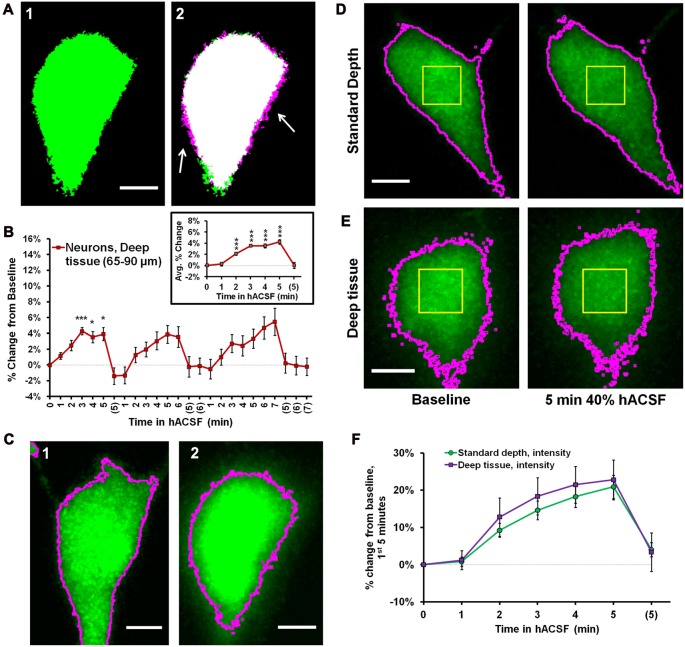
Intensity measurements reveal similar volume change between superficial and deep neurons. (A) Representative thresholded images of a Thy1-eGFP neuron taken from deep tissue (~65–90 μm below slice surface) at baseline (A1) and 5 min 40% hACSF (A2) time points. Magenta regions (indicated by white arrows) show areas of cell volume increase. (B) Volume change in deep Thy1-eGFP neurons exposed to 40% hACSF, measured using our standard analysis method. Inset displays average percent change across hACSF applications. The apparent reduction in volume change as compared to shallower neurons (e.g., Figure 3) is most likely an artifact of lower cellular resolution at depth, which is poorly handled by our standard analysis technique. (C) Illustration of the analysis problem posed by deeper neurons. Raw image MIPs from 5 min hACSF time point for a typical shallow (C1) and deep (C2) neuron, illustrating the analysis problem posed by the latter. Images have been brightened to enhance visibility of the cell border. Magenta lines indicate borders of thresholded area for each cell after final processing (see Figure 3B, Panel (A) for respective thresholded images), from which soma area is typically calculated. Shallower neurons (C1) have well-defined borders in the raw MIP which are almost completely preserved after thresholding, allowing for highly-accurate measurements of soma area in these cells. In contrast, the “fuzzy” borders of deeper neurons (C2) are poorly thresholded and insufficient for detecting volume changes. Scale bars = 5 μm. (D) Standard (thresholding) and microspectrofluorimetric (fluorescence intensity) methods applied to a standard-depth neuron at baseline (left) and 5 min 40% hACSF (right) time points. As in (C), magenta outlines indicate cell area calculated by thresholding. Yellow ROIs denote the 5 × 5 μm region from which average fluorescence intensity was measured. (E) Analysis methods from (D) applied to a deep neuron. While thresholded borders are inaccurate as expected, fluorescence intensity within the yellow ROI decreases to a similar degree between this deep neuron and the more superficial neuron in (D). (F) Percent change over the 1st 5 min of 40% hACSF, calculated from changes in average fluorescence intensity in both standard depth and deep neurons. ***p < 0.001, *p < 0.05, percent change vs. 0% (baseline).